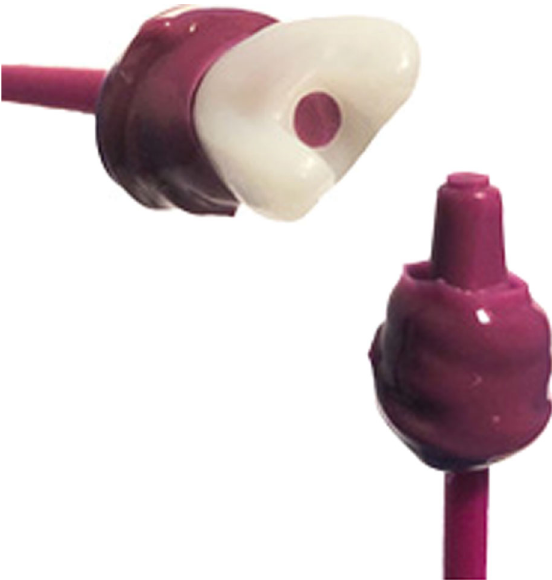
Fig. 3 Silicone replica. Silicone replica with and without zirconia crown.